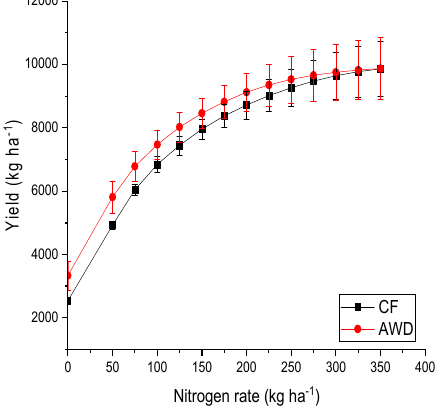
Figure 6. Simulated yield and applied fertilizer N, with AWD and CF conditions. Each value is the average of 45 years between 1961 and 2005. The bars show the standard deviation among years for each N rate.